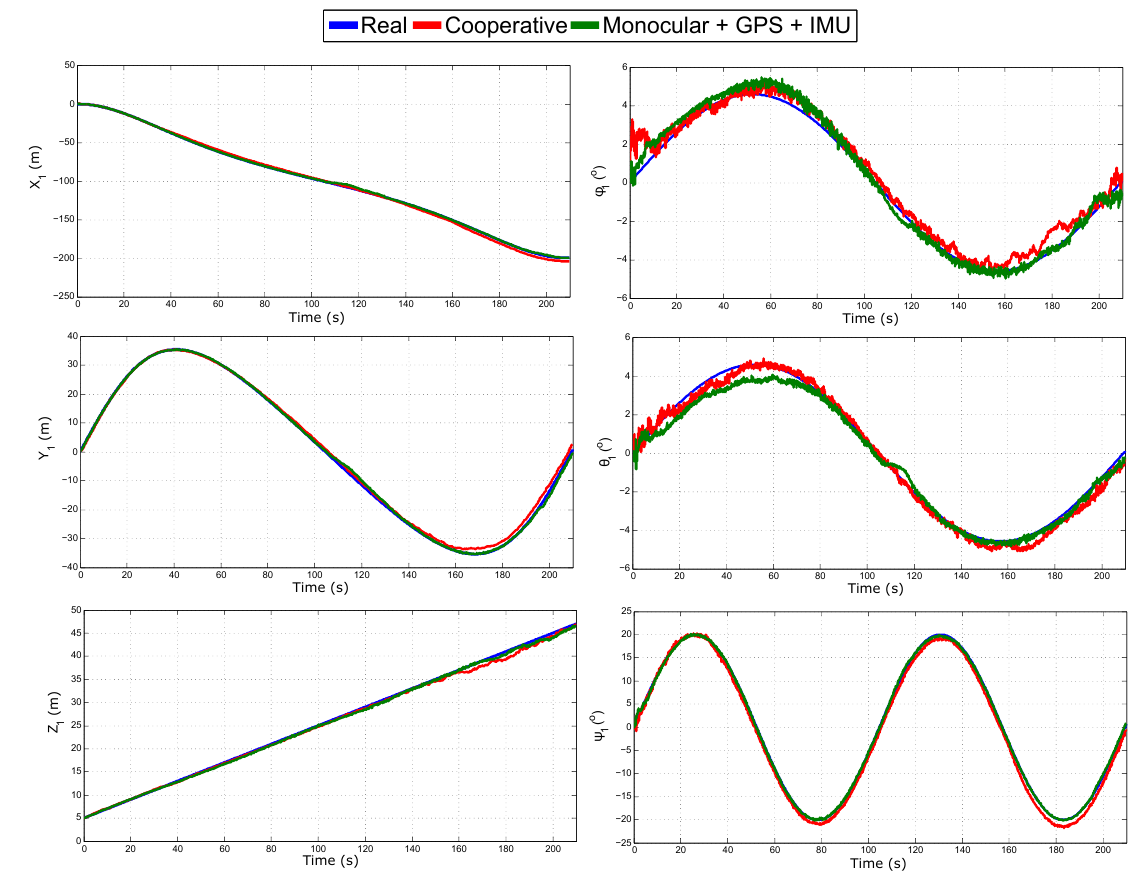
Figure 14. Estimated state of Quad